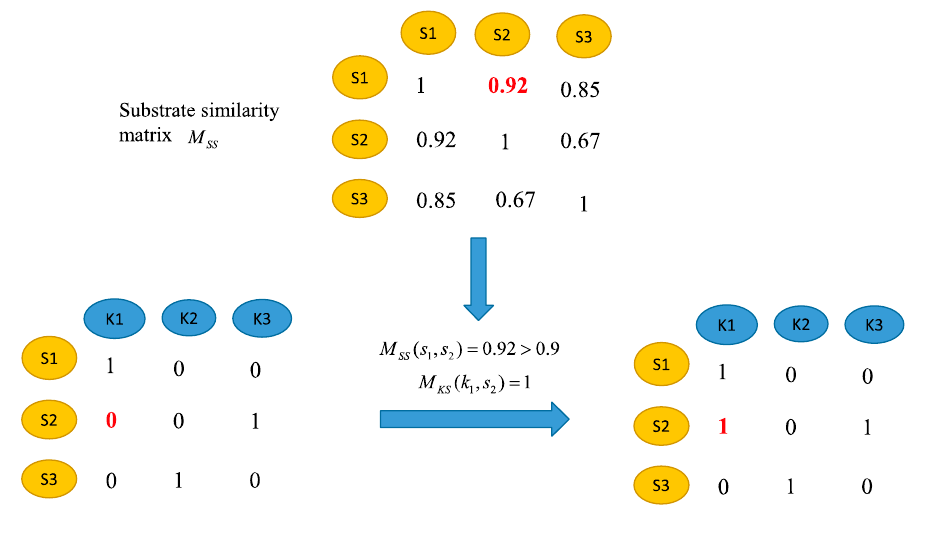
Figure 3. Adjust the kinase–substrate association network.